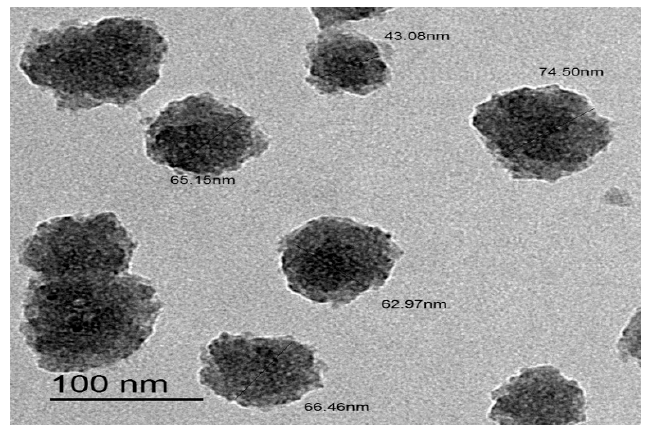
Figure 4. TEM of CH-NPs/Se complexes.